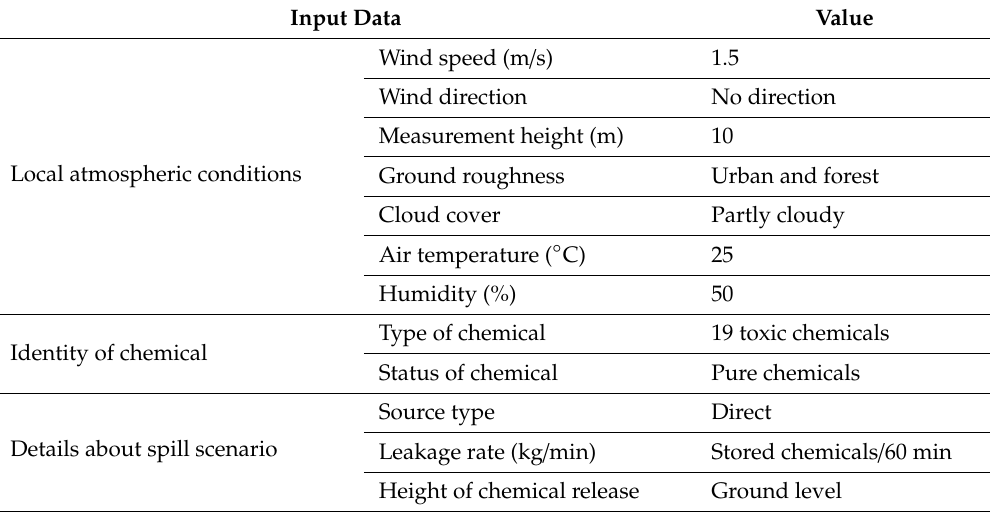
Table 1. Summary of ALOHA input data used in the